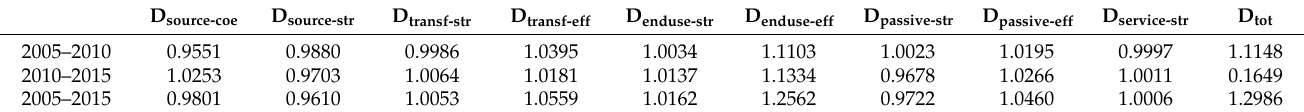
Table 2. Logarithmic Mean Divisia Index (LMDI) decomposition results of driving factors in China.